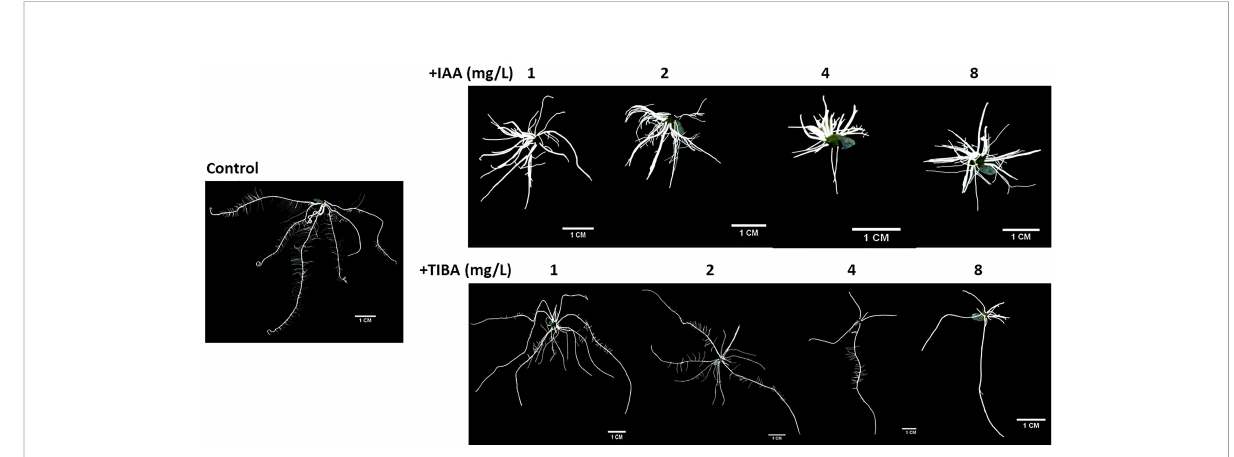
FIGURE 9 Magni fi ed root images under control and IAA/TIBA treatment